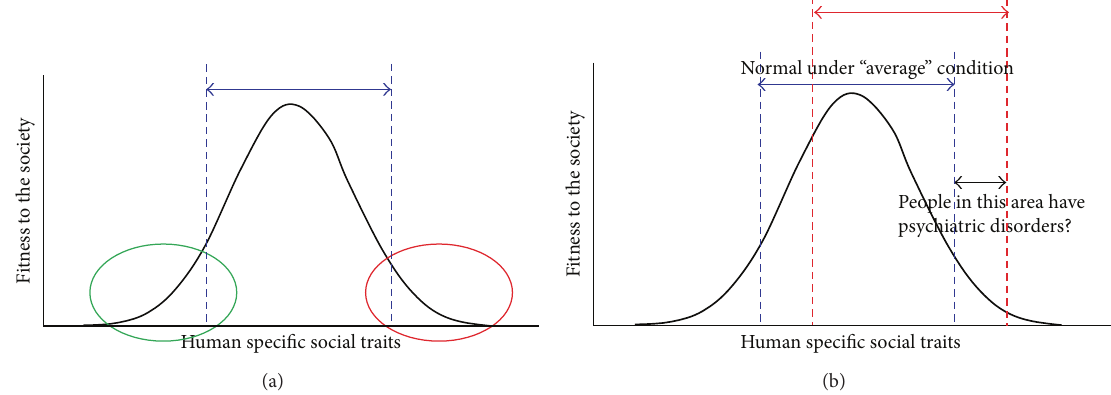
Figure 2: A schematic diagram illustrating that (a) psychiatric conditions may be understood to be the extreme ends of a normal distribution of brain function and (b) whether behavioral phenotypes associated with psychiatric disorders could be advantageous or disadvantageous may depend on the environment.